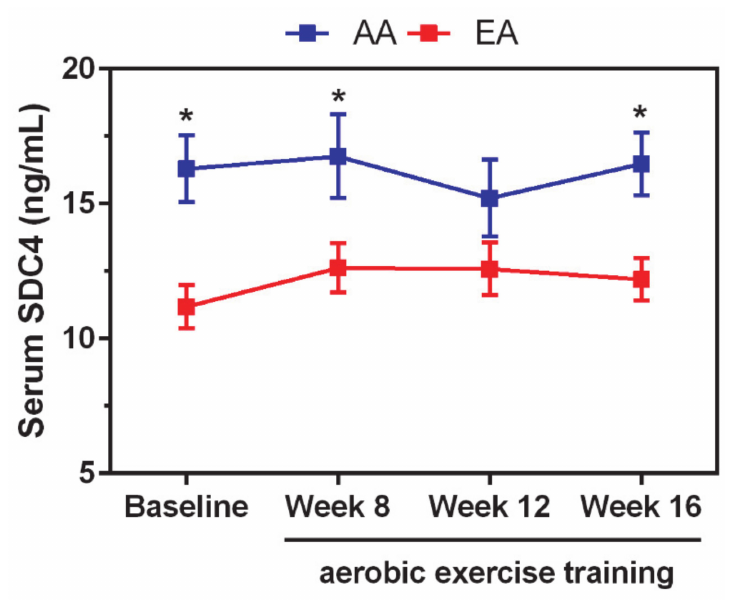
Figure 3. Serum SDC4 levels are not affected by long-term aerobic exercise training. Compared to European Americans (EAs), African American (AA) women showed statistically significantly higher levels of SDC4 at baseline and after 8 and 16 weeks of aerobic exercise regime. However, the levels of SDC4 did not change during the training. Error bars represent standard errors. Significant comparisons were determined by post hoc Tukey’s test at * p <